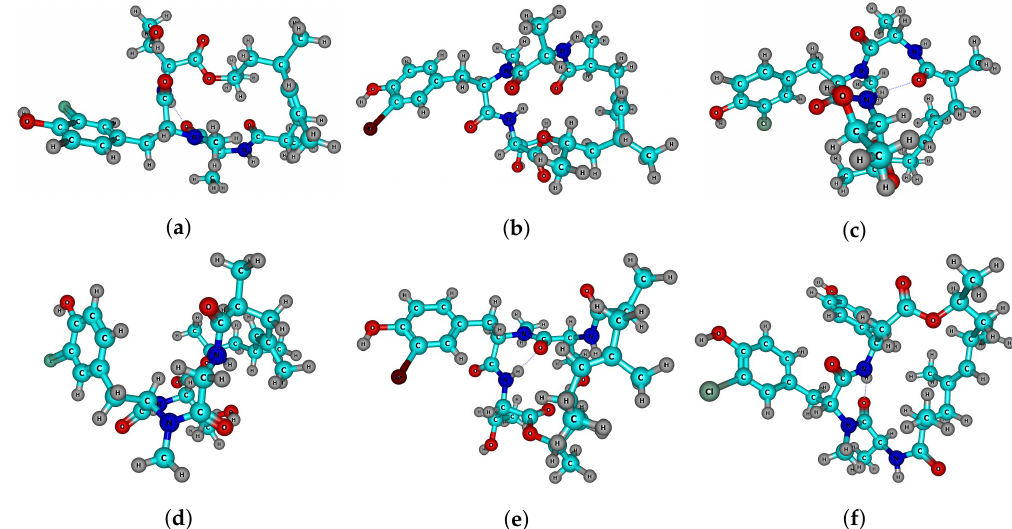
Figure 1. Graphical sketches of the molecular structures of: ( a ) Seragamide A; ( b ) Seragamide B;